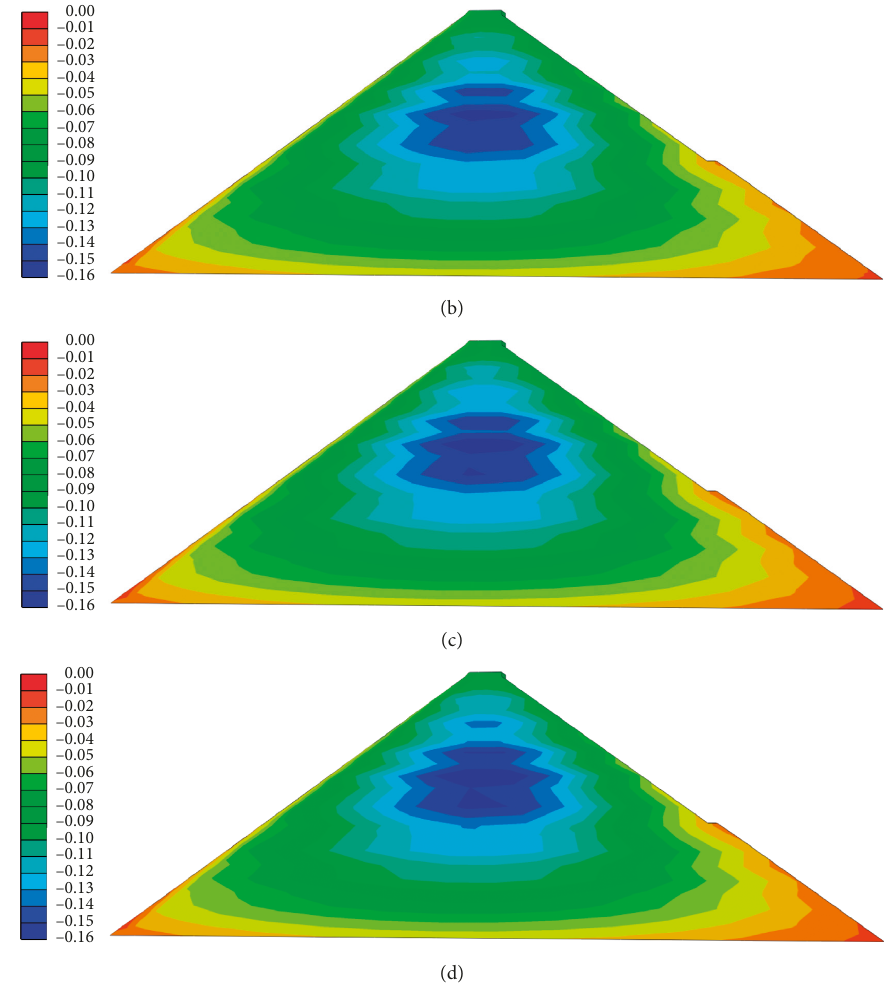
Figure 15: Settlement distributions in section A-A on typical days (m): (a) 1000 days, (b) 2000 days, (c) 3000 days, and (d) 4000